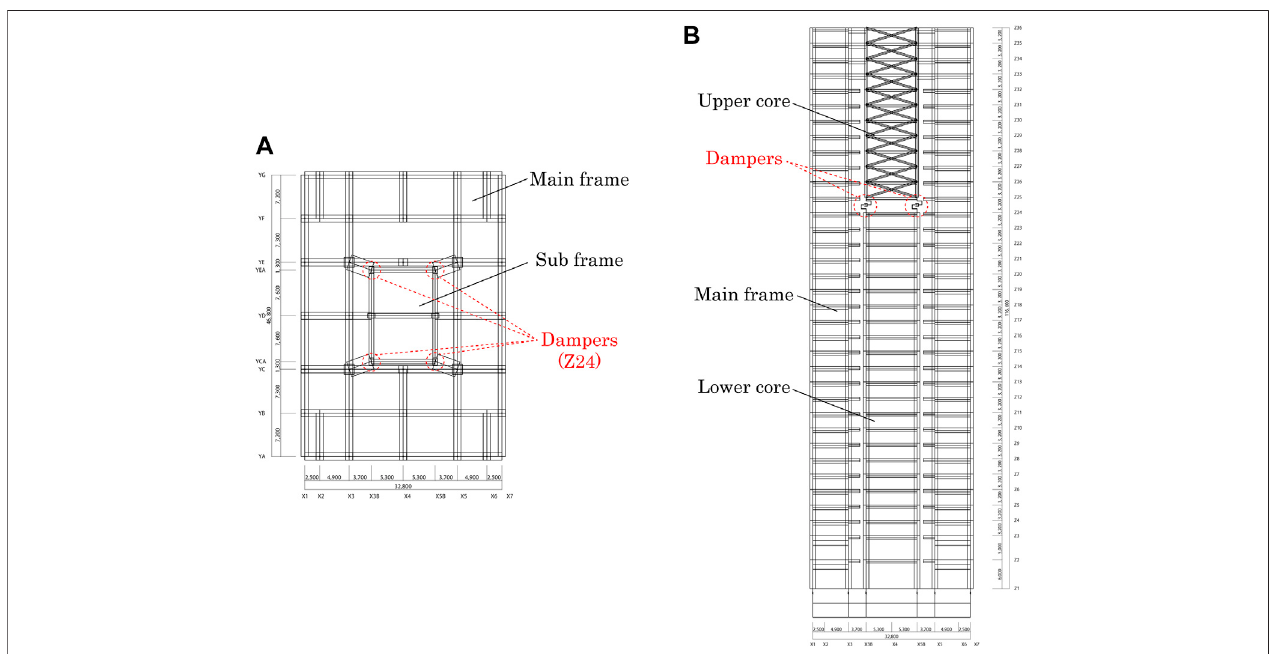
FIGURE 1 | High-rise building with deformation-concentration vibration control system, (A) Plan, (B) Section.